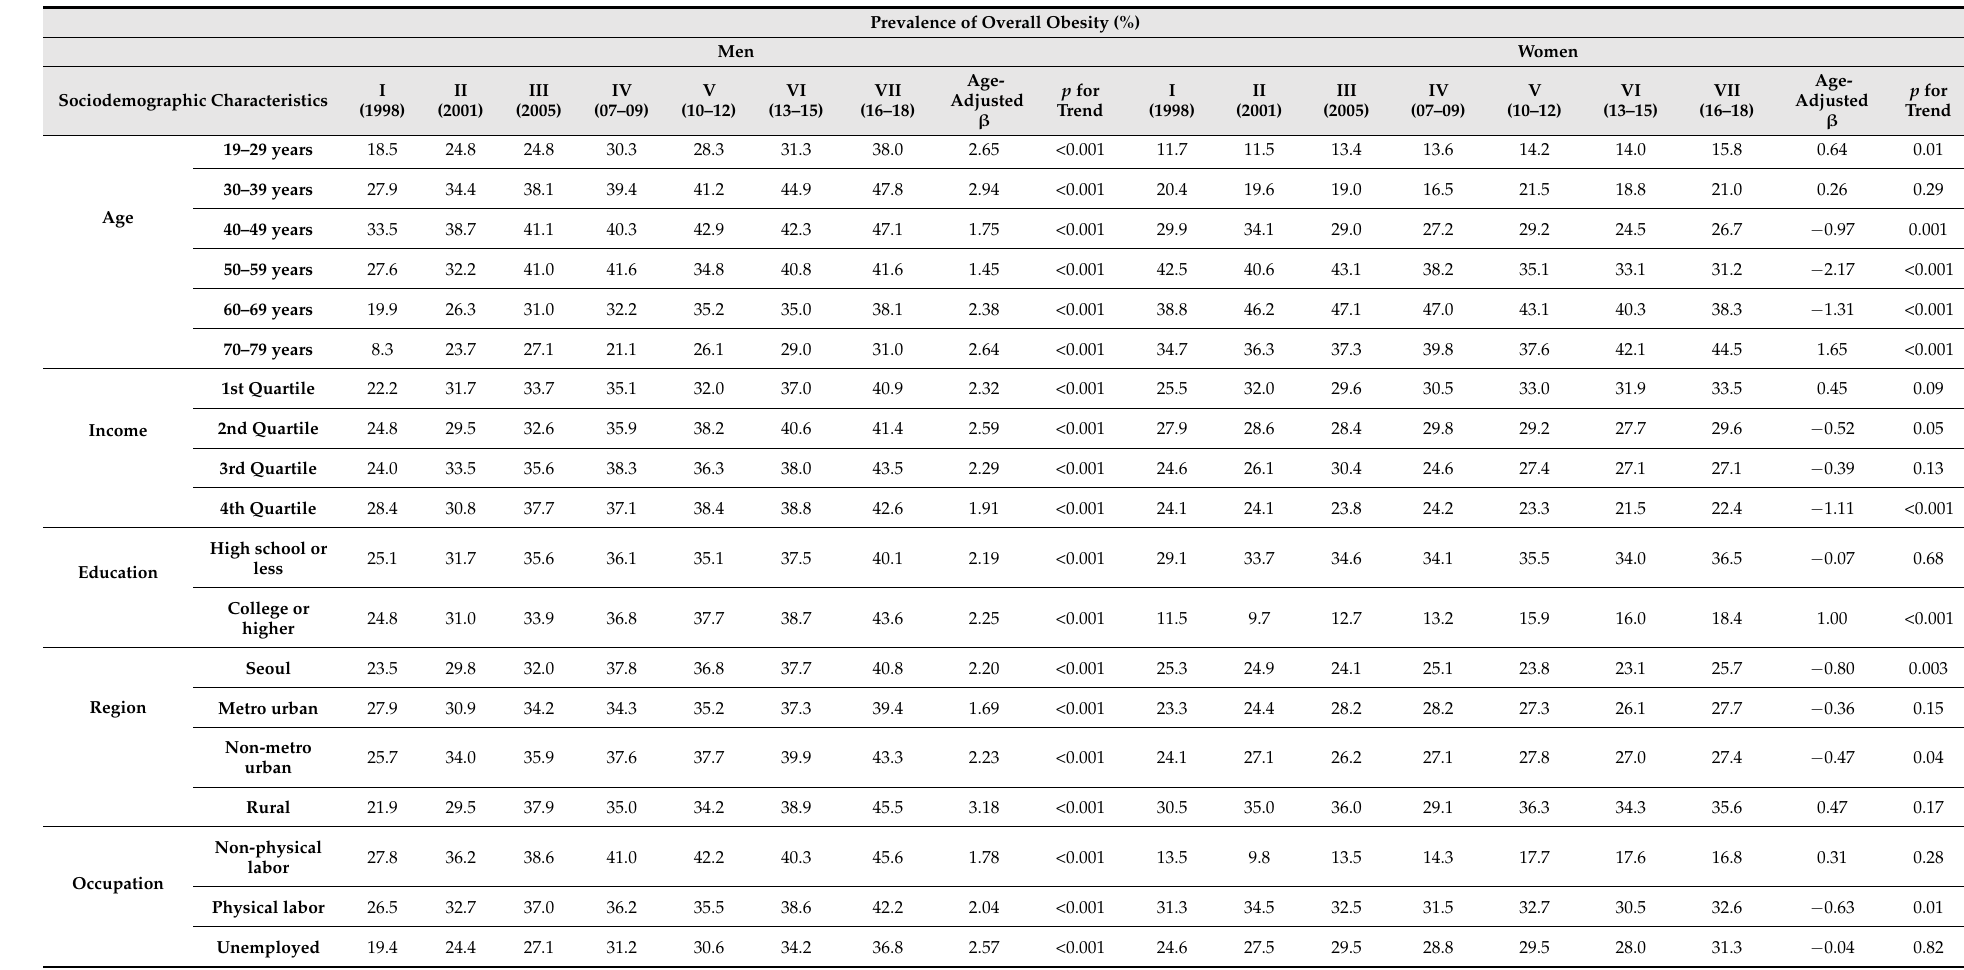
Table 1. Prevalence of overall and abdominal obesity by sociodemographic factors in Korean men and women: the KNHANES I–VII. Prevalence of Overall Obesity (%) Men